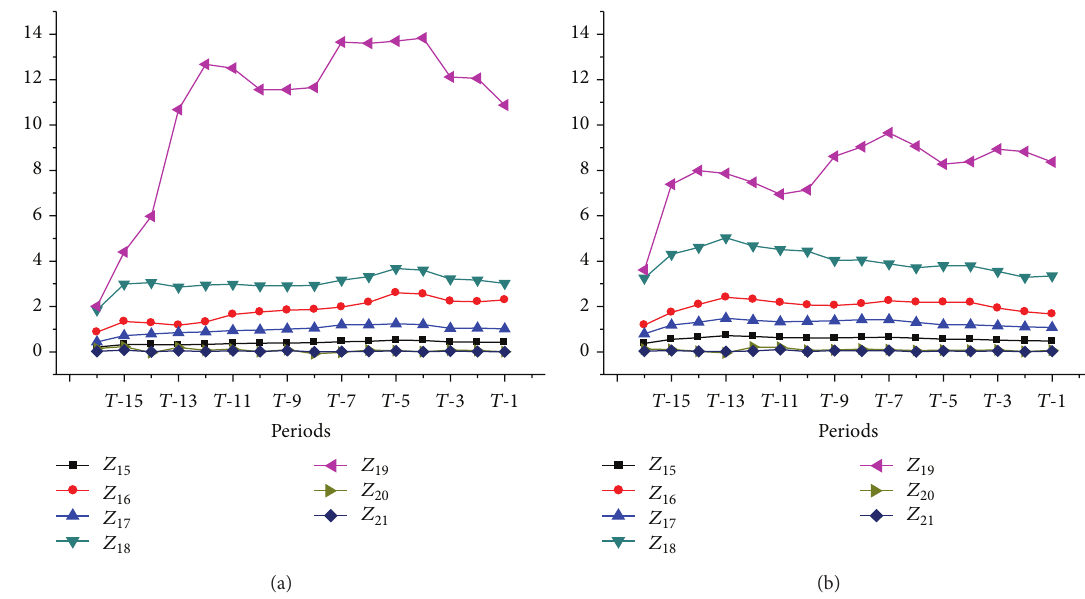
Figure 5: The trend analysis of mean of signal indicators of management efficiency for distress samples and healthy samples.